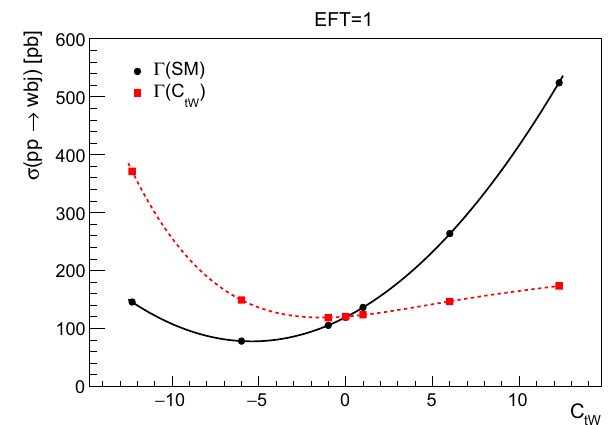
Fig. 7 The cross section of the Wbj production as a function of C tW with two EFT insertions for the width of the top fixed to the SM value of 1.5 GeV (quartic dependence), or computed according to the value of the operator (quadratic dependence)